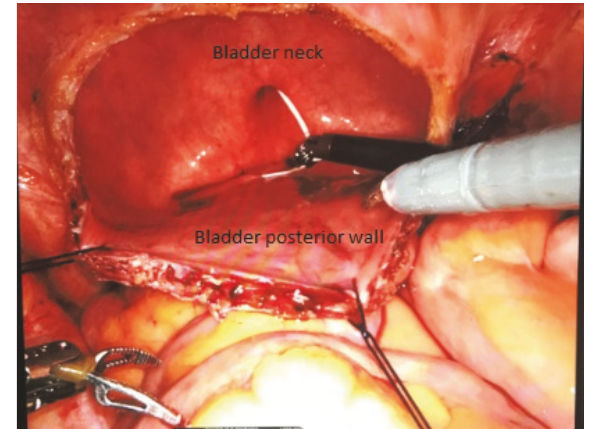
Figure 2: Transperitoneal view of open bladder: a white ureteral catheter positioned through urethra into left ureteral meatus.